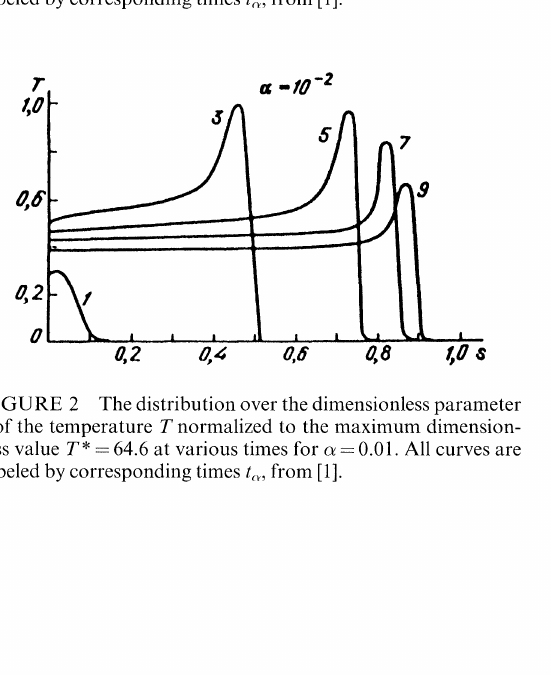
The distribution over the dimensionless parameter of the angular velocity [ normalized to the maximum dimen- sionless value 2" at various times for c 0.01. All curves are labeled by corresponding times t, from ].